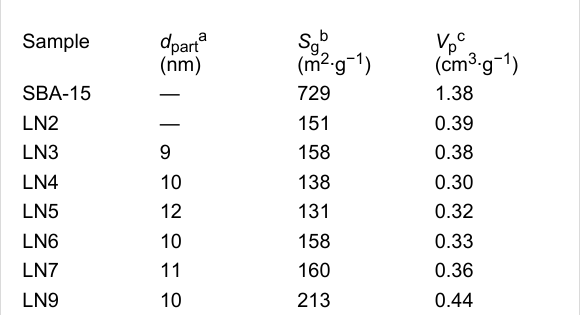
Table 1: Textural characterization of as-prepared LiNbO 3 /SBA-15 composites (LN).